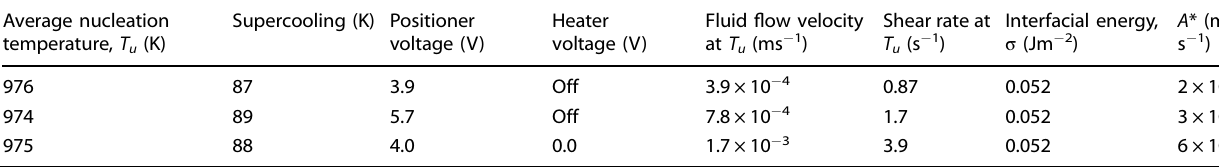
Table 3. Experimental data for Ti 39.5 Zr 39.5 Ni 21 . Average nucleation temperature, T u (K)